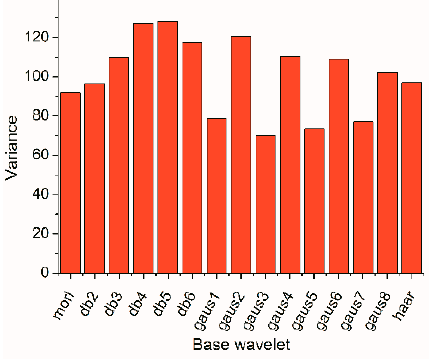
Figure 11. Comparison between the signals from Baker’s method and the proposed method in this paper. Appl. Sci. 2018 , 8 , x FOR PEER REVIEW